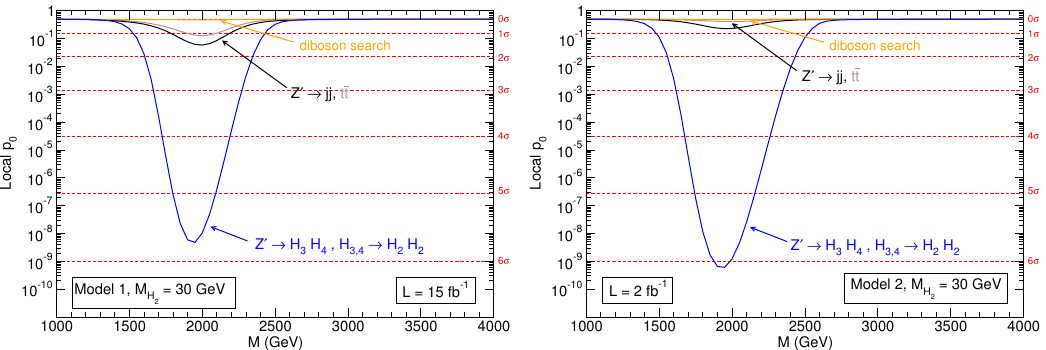
Figure 5 . Expected local p -value for the Z 0 signal in the various searches, for scenario 1 of model 1 (left) and model 2